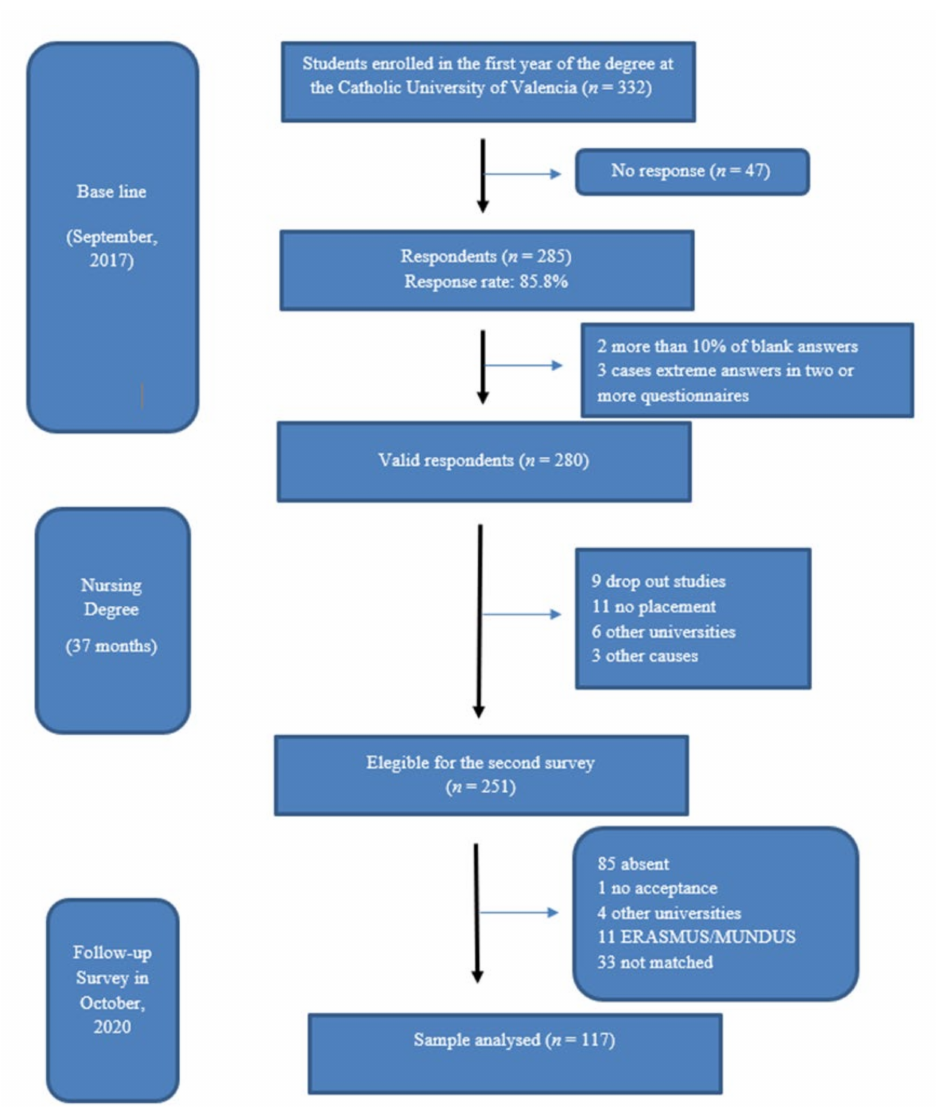
Figure 1. Participant flow of the present study. ERASMUS/MUNDUS: EuRopean/World Community Action Scheme for the Mobility of University Students.